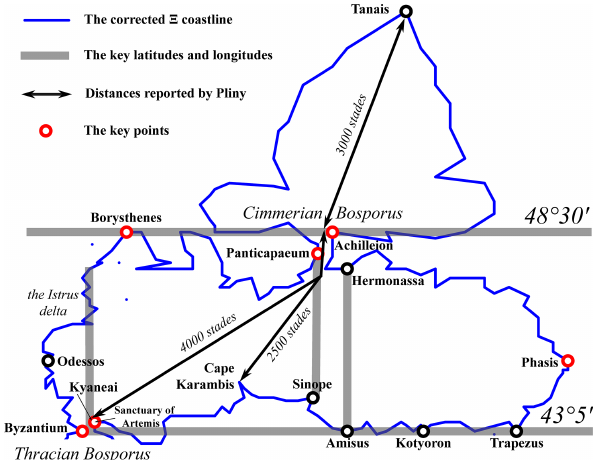
Figure 1. The “constituent elements” of the Pontus Euxinus in Ptolemy’s Geography : the key points, latitudes, longitudes, and dis- tances determining its basic outlines on his map (according to the corrected version of the (cid:52) recension). This and all of the follow- ing maps in the paper are drawn using the projection that Ptolemy ascribes to his immediate predecessor Marinus of Tyre ( Geogr . 1.20.3–5). In modern terms, it is an equidistant cylindrical projec- tion, in which the coordinate net consisted of two families of mutu- ally orthogonal parallel lines, and distances are preserved along all the meridians and along only one parallel, which was the parallel of Rhodes (36 ◦ ) in Marinus’ case. Correspondingly, the east–west spacing of places situated north of this parallel is progressively ex- panded the further north they